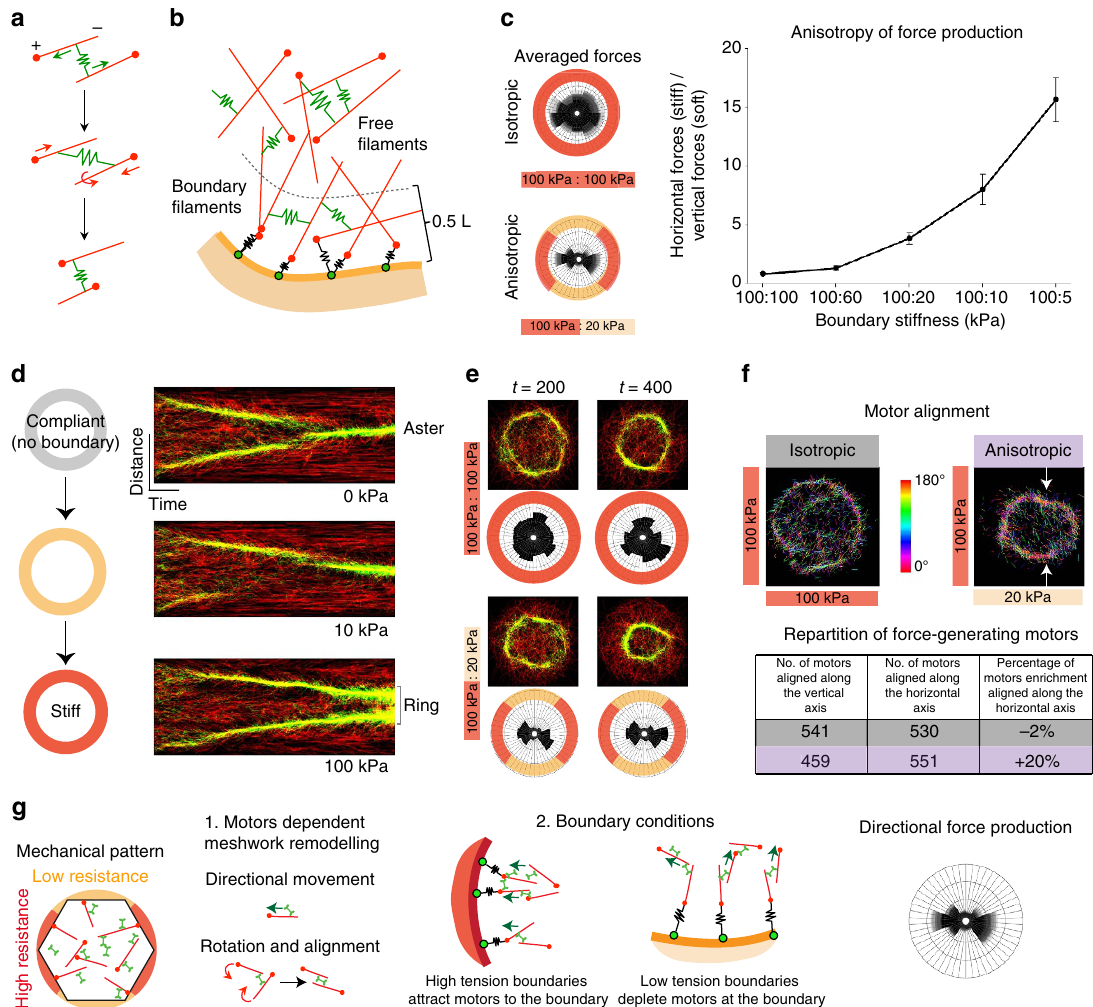
Figure 5 | 2D in silico actomyosin cortex predicts that external constraints alter cytoskeleton organization and force direction. ( a ) F-actin is modelled by polar filaments (red) and motors by springs (green). As motor exerts force on filaments, filaments translocate and/or rotate. ( b ) Within a perimeter of 0.5 filament length, the plus ends of the filaments are caught by springs with defined stiffness to model boundary resistance. ( c , left) To simulate isotropic constraints, boundary springs (stiffness ¼ 100kPa) were equally distributed around the boundary. To simulate anisotropic constraints, softer springs (20kPa) were placed at the top and bottom of the boundary. The rose diagrams illustrate the average force generated on boundary springs for each condition ( n Z 10 simulations), and circle divisions represent 10nN. (Right) The ratio of force production along stiff (left/right) over soft (top/bottom) axes was calculated and plotted depending on increasing values of stiffness anisotropy between left/right and top/bottom boundary springs; n Z 10 simulations per conditions. Error bars represent s.d. ( d ) Kymographs representing the contraction of the network into an aster (top) or the stabilization of a ring-like structure (bottom) depending on the resistance of the boundary. ( e ) Images of representative simulations at two time points showing motor (green) and actin filament (red) organization. The associated rose diagram illustrates forces generated on the boundary by these networks, and circle divisions represent 10nN. Top, isotropic boundary. Bottom, anisotropic boundary. ( f ) Motor alignment for simulations with isotropic or anisotropic boundaries ( t ¼ 250 time-steps). The motors are colour coded based on angle relative to the horizontal axis, with red motors being most aligned with that axis. Anisotropic boundary constraints resulted in motors aligned with the stiff (horizontal) axis along the top and bottom of the oval-like myosin structure (arrows). Quantification of motor alignment is given in the table. Numbers highlighted in grey correspond to the isotropic case and numbers highlighted in purple to the anisotropic case. There is a 20% enrichment bias in motors aligned along the stiff horizontal axis when the resistance of the boundary is anisotropic. ( g ) Model illustrating the factors that influence motor movement and alignment, and force production in response to asymmetric boundary